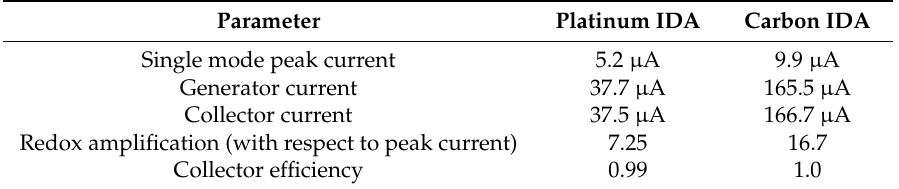
Table 1. Stationary measurements in dual and single mode on platinum and carbon